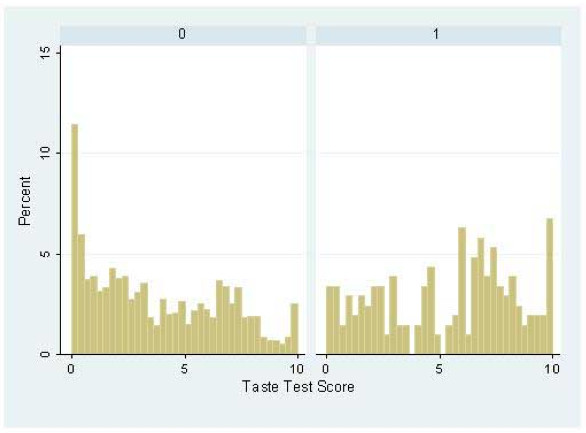
Disrtibution of PROP taste test scores by the rare AA haplotype in the ALSPAC cohort. Test groups here correspond to 1 = any carriage of the rare AA haplotype, excluding carriers of the common PA taster haplotype, i.e. predicted intermediate tasters; 0 = all other individuals. Ranksum analysis for comparison of random points from these two distributions yields p =< 0.001.